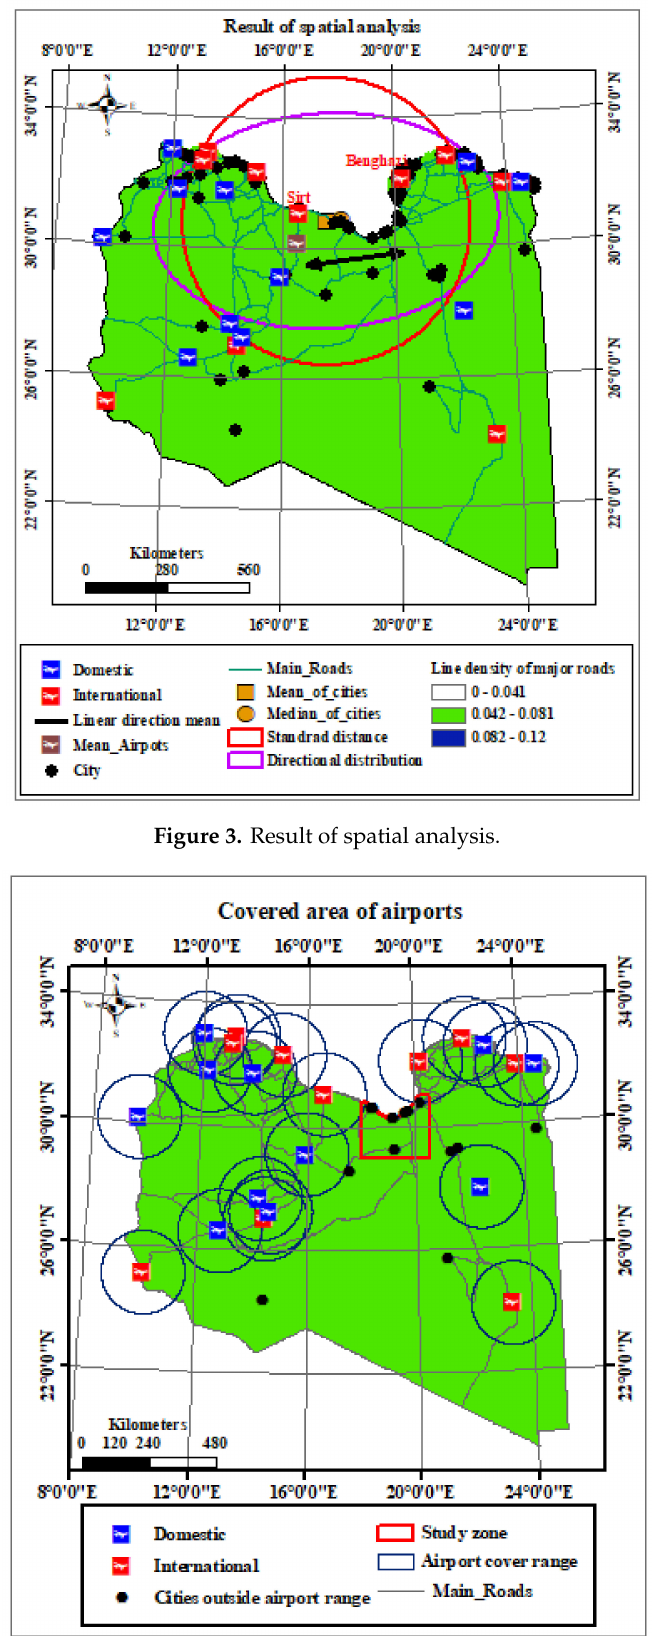
Figure 4. Cities outside the airports’ range